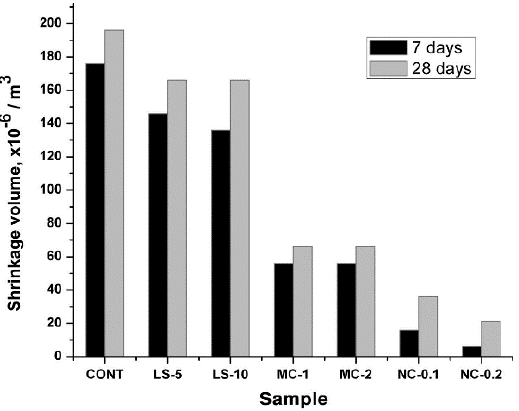
Figure 10. Changes in shrinkage properties of concrete after incorporation of NC [98].